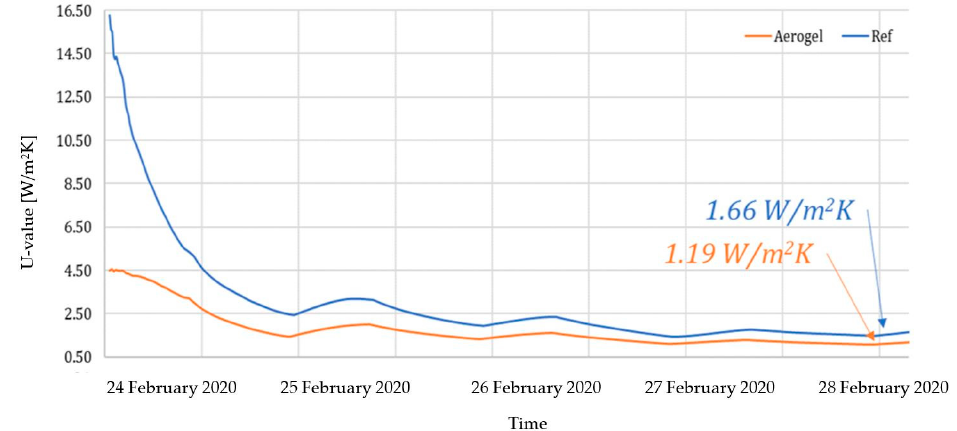
Figure 8. Thermal transmittances obtained from the U-value measurements.